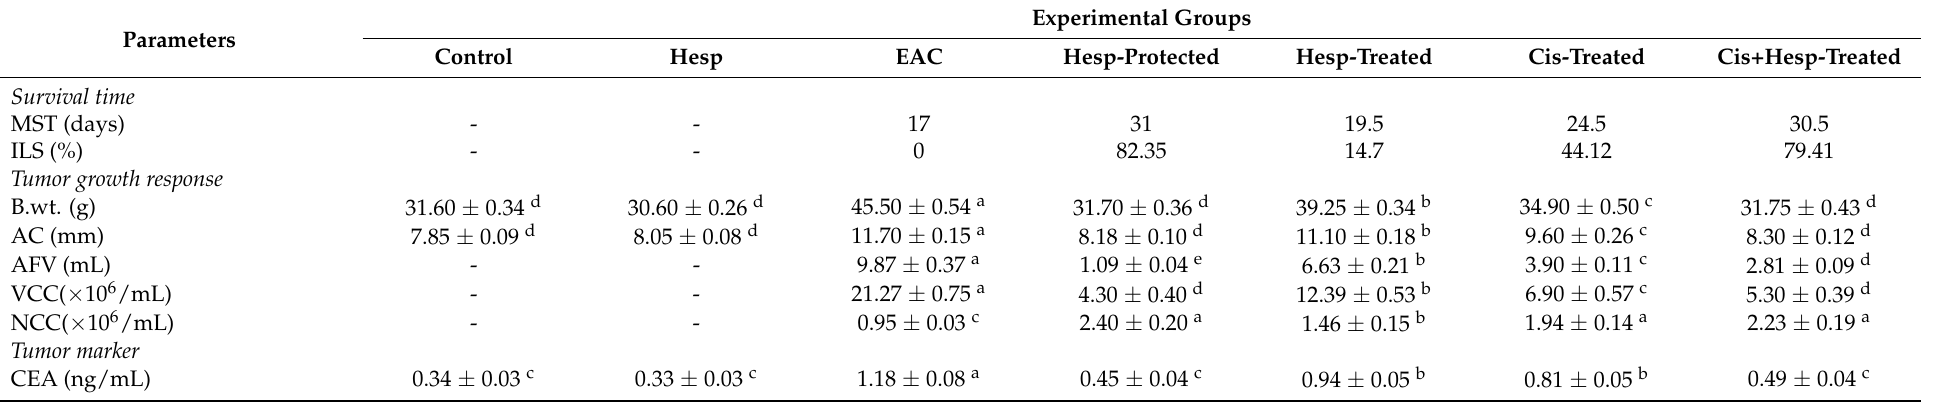
Table 1. Effect of hesperidin and/or cisplatin on survival time, tumor growth response parameters, and serum tumor marker of EAC-bearing